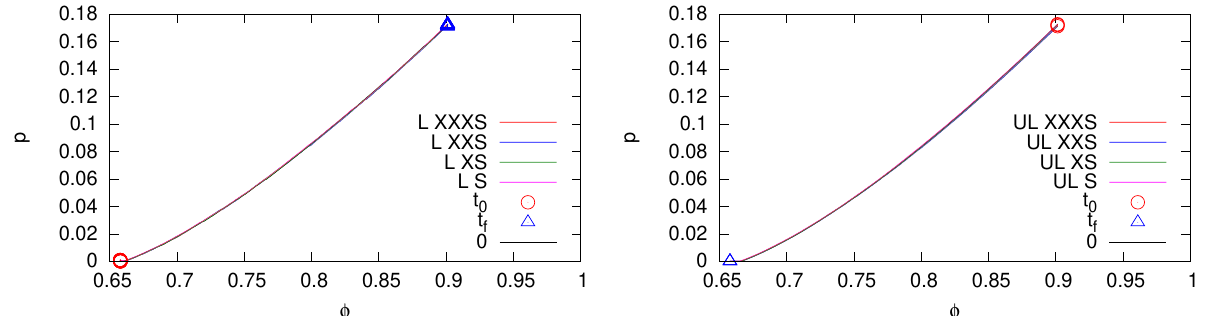
Figure 1. Dimensionless pressure p = p (cid:48) d / k n plotted against volume fraction for loading (left) and unloading (right) with di ff erent strain rates indicated in the legend (every X means 10 times slower), as explained in the main text. Note that the data almost collapse, i.e., for these slow strain rates, pressure is almost independent of rate. The symbols at t 0 and t f mark beginning and ending of the simulations, respectively.